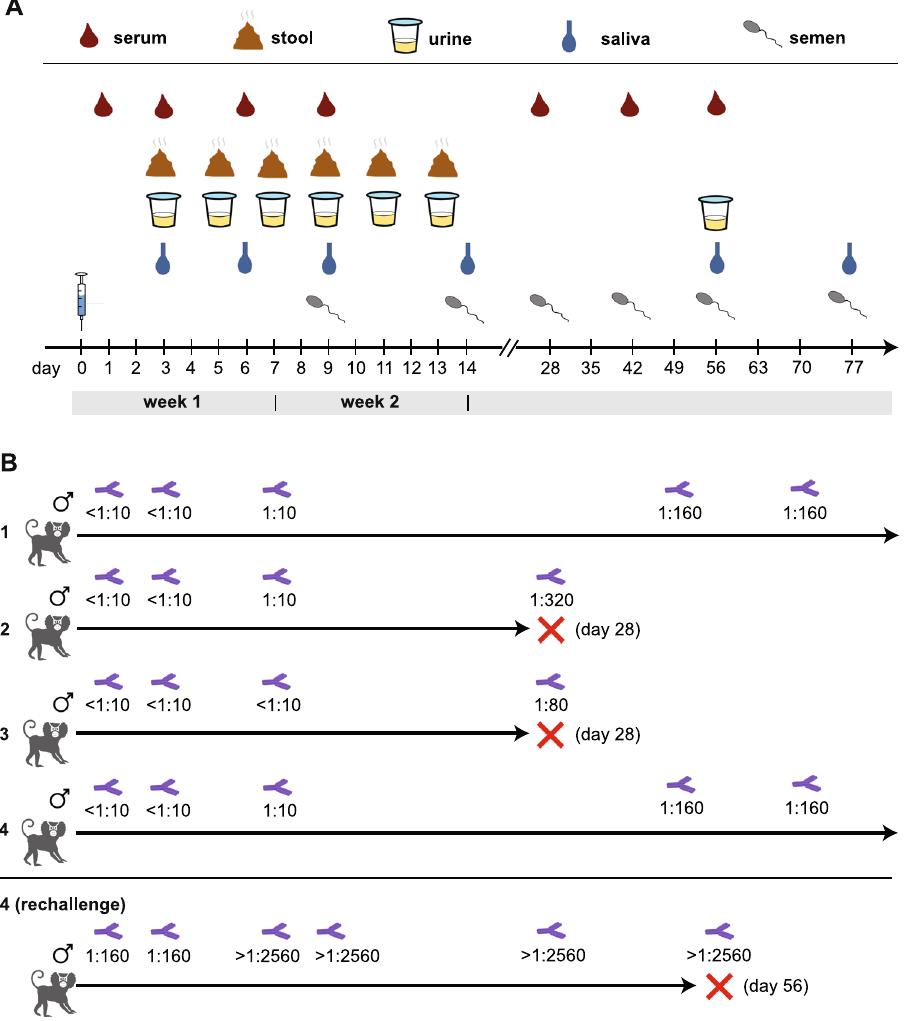
Figure 1. Study design and neutralizing antibody testing. ( A ) After intramuscular inoculation of ZIKV at day 0, samples (serum, stool, urine, saliva, and semen) are collected at predesignated time points. ( B ) Longitudinally collected serum samples from inoculated marmosets were tested at predesignated time points for ZIKV-specific neutralizing antibodies using a PRNT (plaque reduction neutralization test). The antibody titer as determined by PRNT at a given time point is shown below the icon. Three of the 5 marmosets were sacrificed after approximately 1 month (denoted by a red “X”) to assess viral persistence in